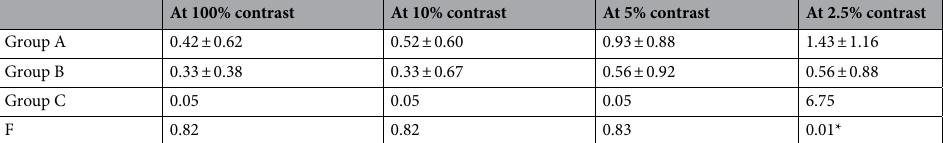
Table 5. The average BiS records (x ± s lines) for high and different low contrasts in patients with and without central fusion after strabismic surgeries. *P < 0.05.